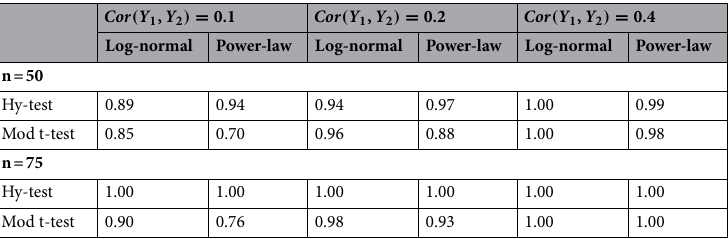
Table 3. Results of simulation block (b), where two vectors of paired synthetic expression profiles ( Y 1 , Y 2 ) , have to satisfy (1) E[Y 2 ] − E[Y 1 ] = 1 and (2) Var[Y 1 ] = Var[Y 2 ] = 0.25 . Average rejection rates after 250 Monte Carlo replicates is reported for two different sample sizes, i.e., n ∈ { 50, 75 } , and distributions (log- normal and power-law), after adjusting the p-values with the Bonferroni